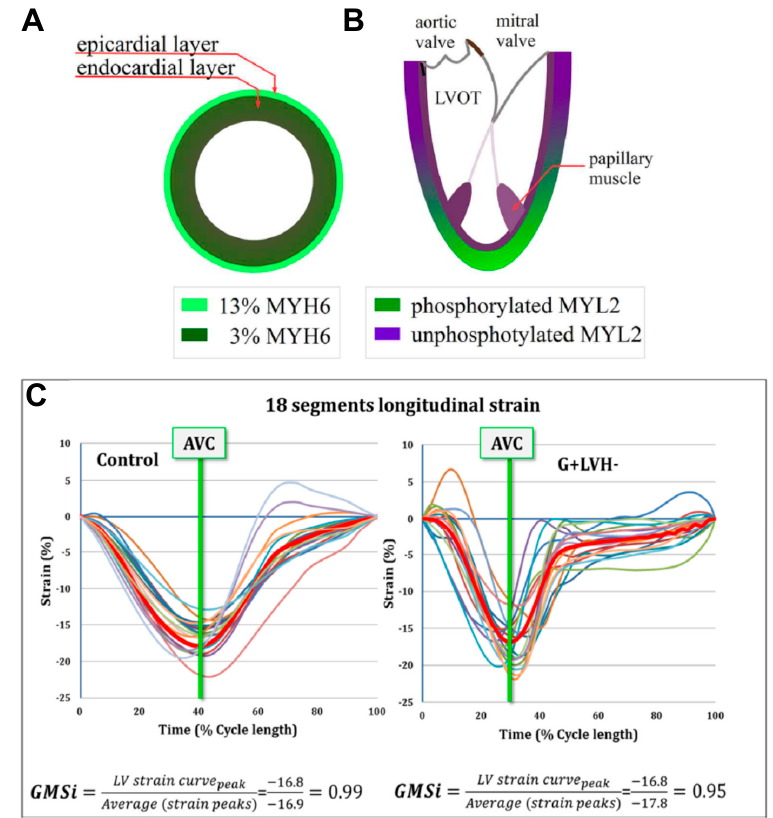
Figure 7. Macroscopic contractile non-uniformities between different parts of the left ventricle. ( A ) Percentage expression of the fast α -myosin (MYH6 gene) out of all myosin ( α -myosin and slow β - myosin) varies between the subendocardial and subepicardial layers of the myocardial wall. ( B ) RLC (gene MYL2) phosphorylation level exhibits a basal–apical gradient leading to important effects on ventricular and valvular mechanics [35,204]. ( C ) Local longitudinal strain (differently colored traces; segment shortening, negative; lengthening, positive) in different parts of the ventricular wall during systole in genotype negative (control) individuals and in mutation carriers (G+, LVH − ). Note the different behavior in mutation carriers compared to controls with greater non-uniformities during the early phases of systole, including noticeable elongation of some segments. AVC: aortic valve closure. GMSi: global mechanical synchrony index. GMSi < 1.0 suggests dyssynchrony. Panels ( A , B ) reproduced from Reference [35] under license CC-BY. Panels ( C ) reproduced from Reference [31], with permission from